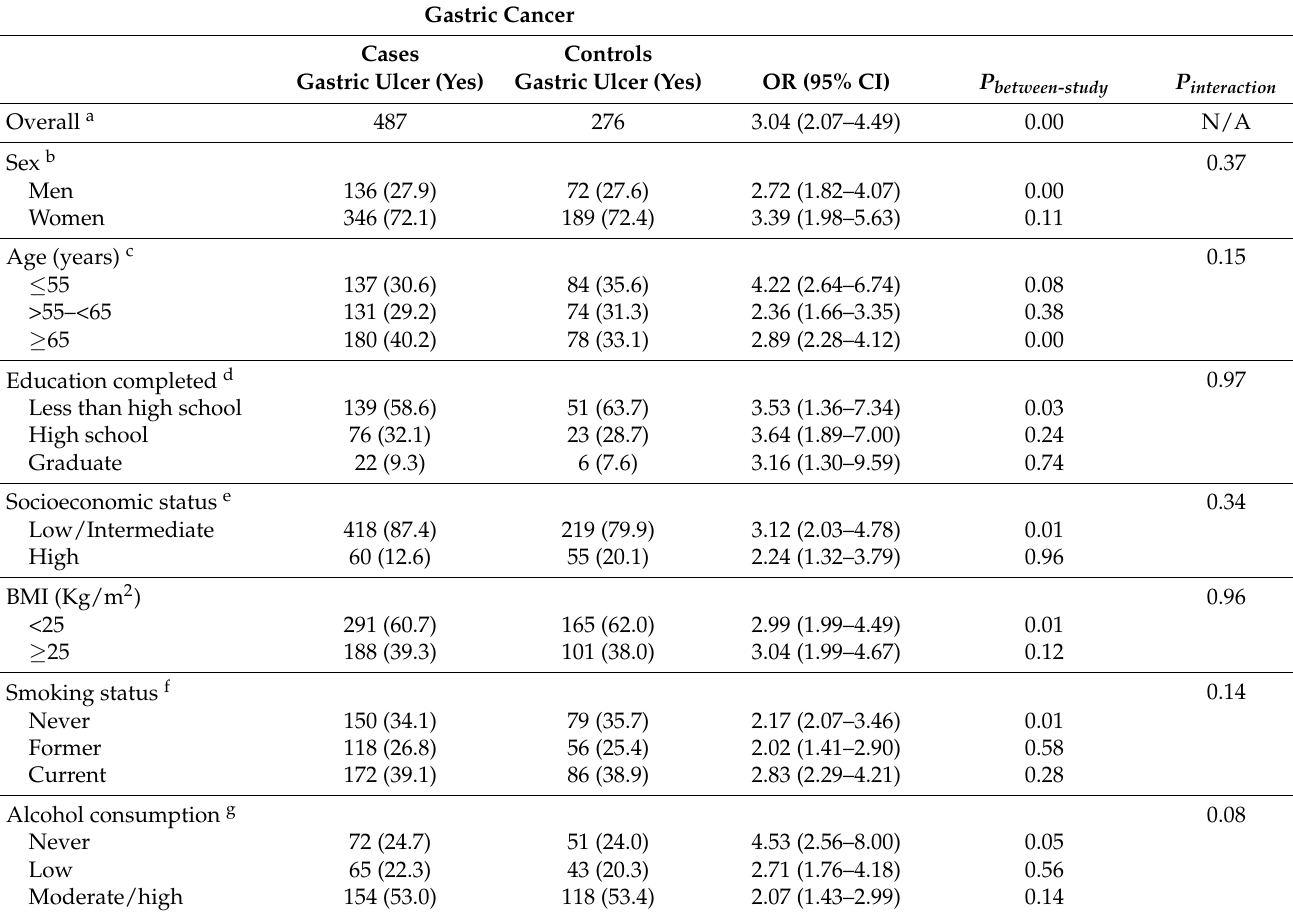
Table 2. Association Between Gastric Ulcer and Gastric Cancer, Stratified by Selected